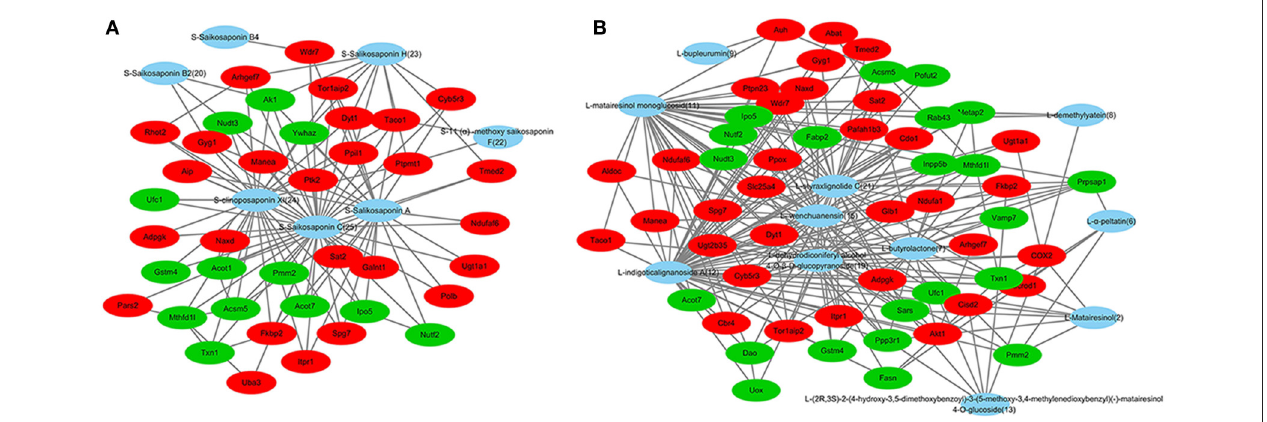
FIGURE 6 | Compound–target networks related to ZYCH effects on DMN-induced liver fibrosis. (A) C-T network of triterpenoid saponins and targets. (B) C-T network of lignans and targets. Red ellipses are up-regulated proteins, and green ellipses are down-regulated proteins in proteomics. Blue ellipses are compounds.